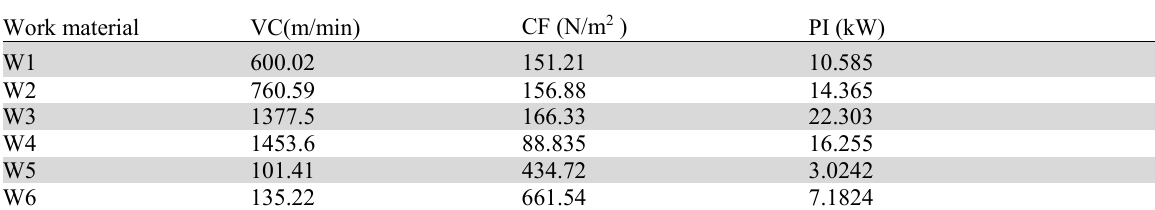
Root-weighted decision matrix for all